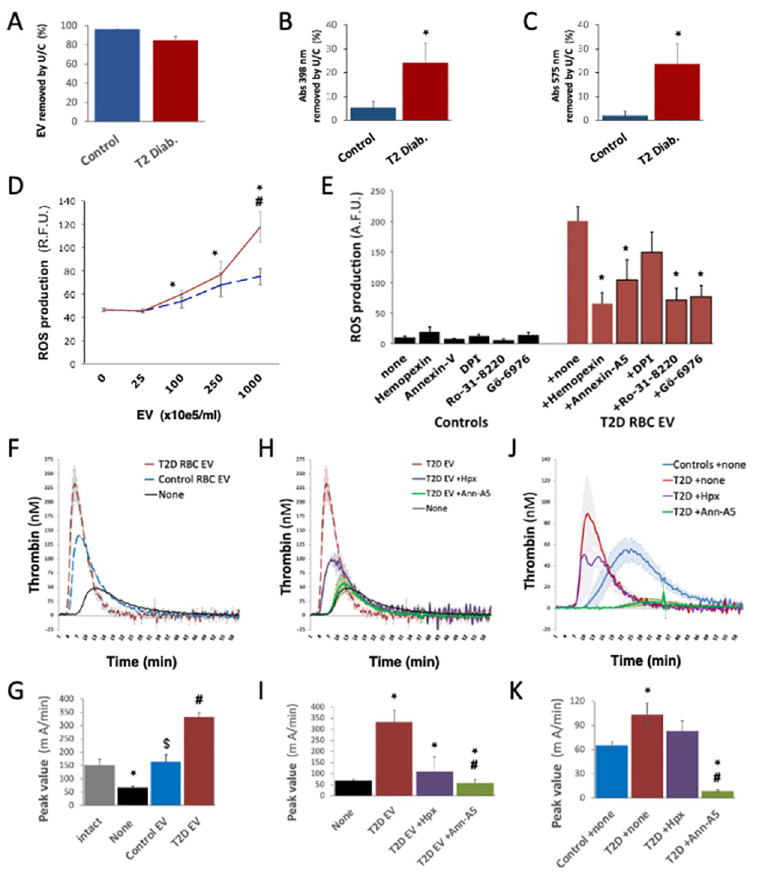
Fig 3. EV from T2D RBC carry heme, stimulate oxidative stress and support thrombin generation. EV shed by T2D RBC after Ca2+ influx were characterized. EV removed from RBC supernatants by ultracentrifugation were quantified by nanoparticle tracking analysis (NTA) (A) , and the drop in heme-related absorbance at 398 nm and 575 nm by spectrophotometry (B-C) . RBC EV (up to 10e8 EV/mL) were applied to cultured endothelial cells (HUVEC). Radical oxygen species production was quantified by fluorescent probe after 1 hour, in the presence of heme- antagonist hemopexin (Hpx), PS-neutralizing annexin-A5, NADPH oxidase inhibitor diphenyleneiodonium chloride (DPI), or the protein kinase-C inhibitors Ro-31-8220 and Go¨-6976 (D-E) . RBC-derived EV triggered endothelial ROS production in a dose-dependent fashion, above 10e7 EV/mL. We used thrombin activation (CAT assay) to detect the ability of EV to support PS-mediated reactions. To focus on EV surface PS, we added control or T2 diabetic RBC EV (10e9 EV/mL) to EV-depleted, platelet-free control plasma, and implemented CAT without synthetic phospholipids (F-I) . Alternatively, we used platelet-free with endogenous EV, supplemented with hemopexin (Hpx) or annexin-A5 (J-K) . We show curves of thrombin generation over 60 minutes (F,H,J) and maximum peak values (G,I,K) . Thrombin generation was increased and accelerated in T2D vs. control plasma, in an annexin-A5-dependent fashion. ( � ) p < 0.05 vs. Controls. (#) p < 0.05 vs T2D